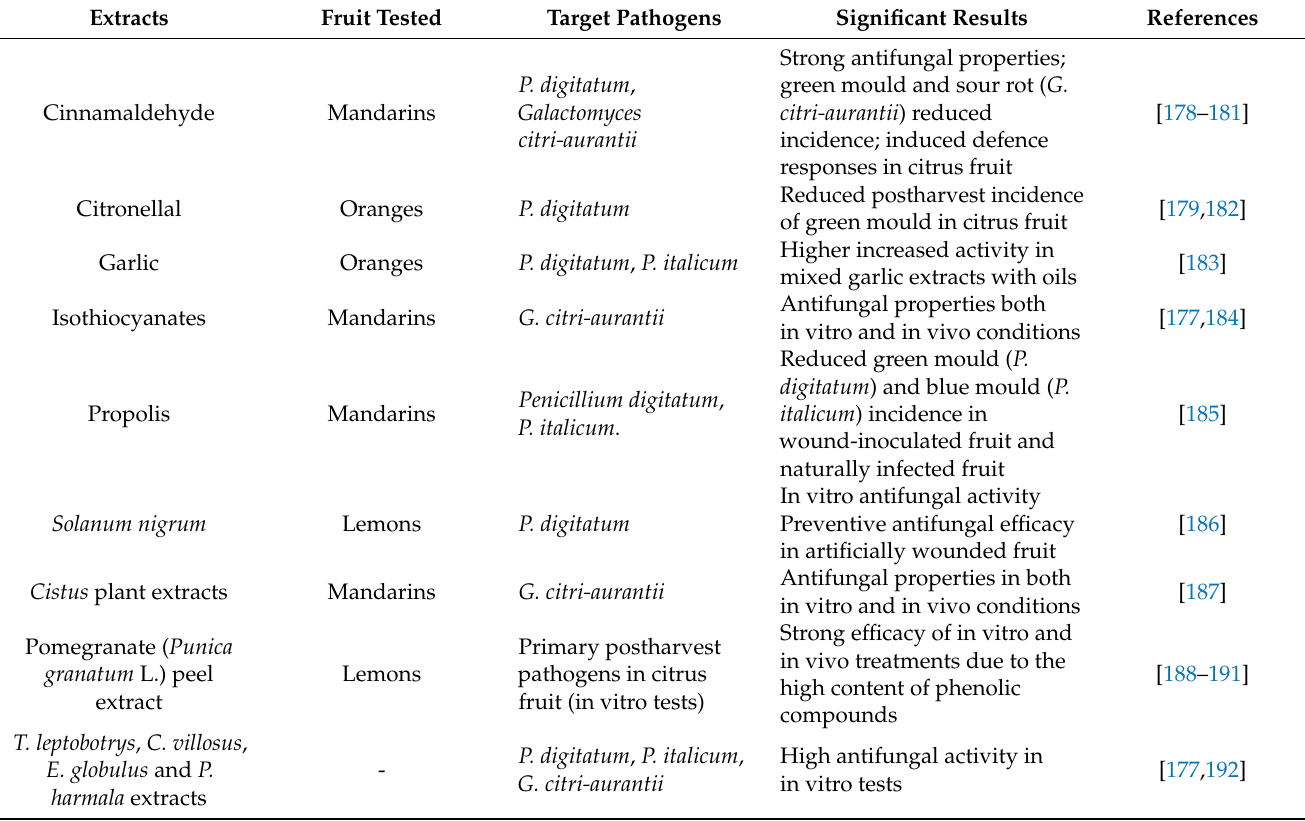
Table 4. Efficacy of plant extracts on postharvest decay control in citrus